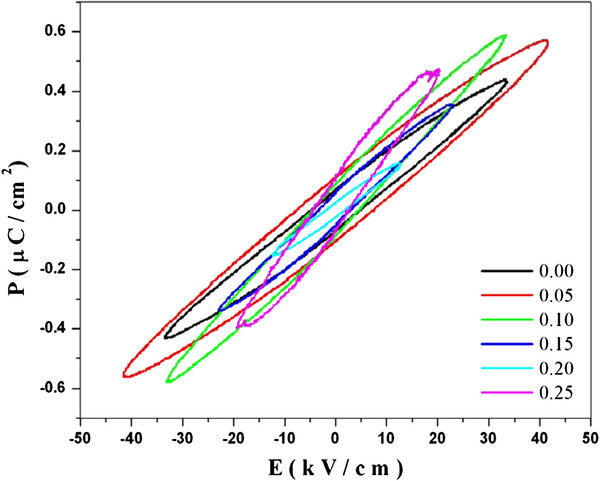
Polarization-electric field loop for Bi4 −xNdxTi3FeO12nanoparticles.